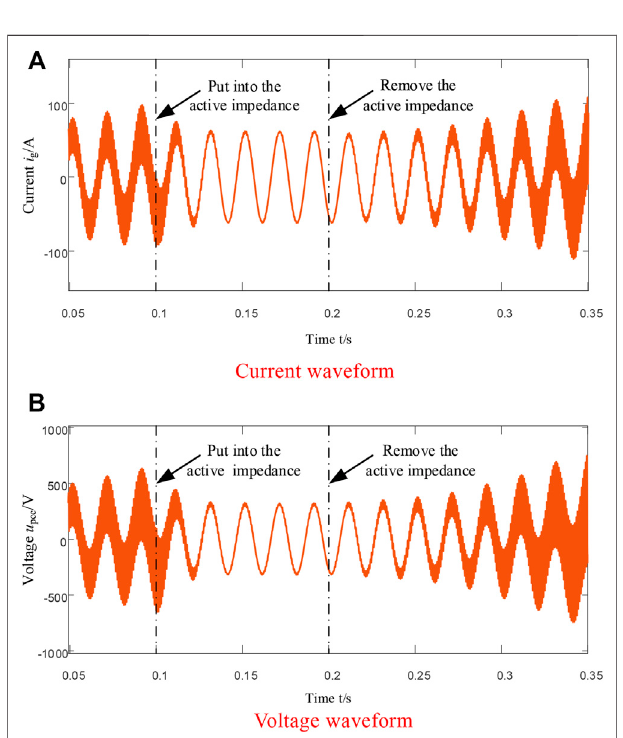
FIGURE 16 | Waveform of grid-connected current and PCC voltage.